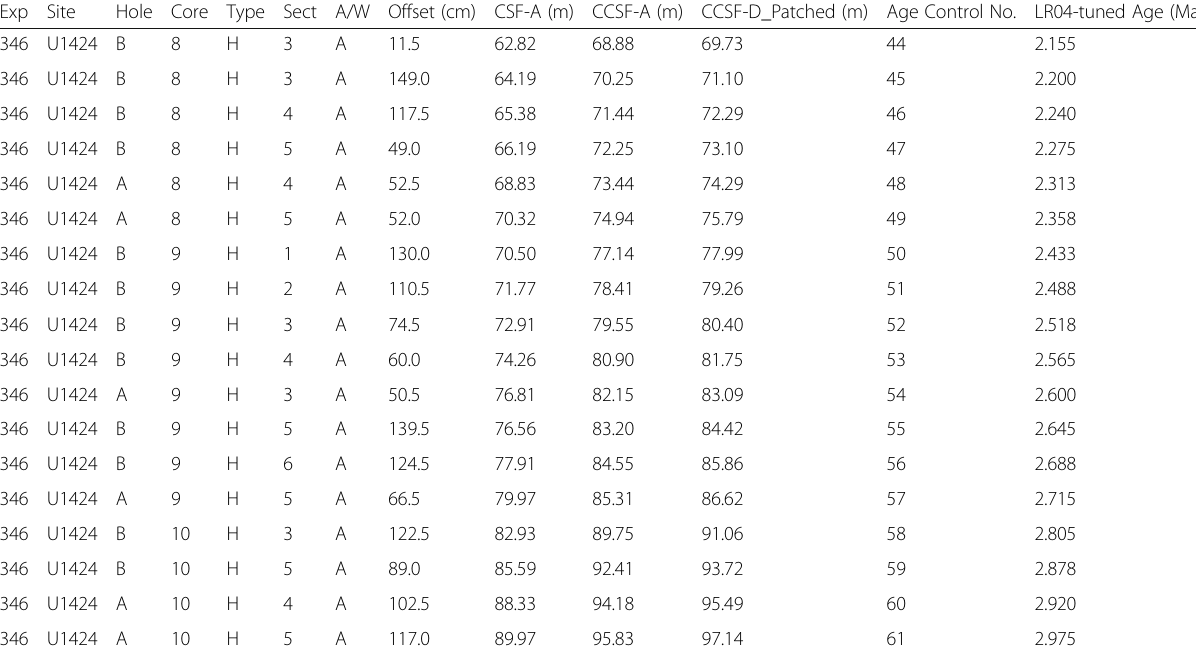
Table 2 A list of correlation point numbers, their depths (CCSFD_patched) on U1424 composite column, and their corresponding ages on LR04 δ 18 O stack profile. Correlation points are also shown in Additional file 2: Figure S2 (Continued) Exp Site